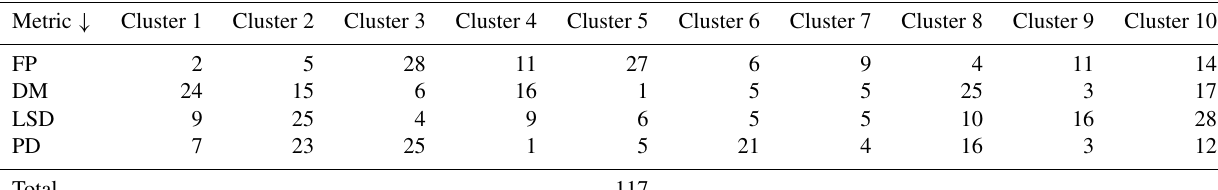
Figure 20. Variation in fracture orientations and topological summary for Region 2 corresponding to (a) fingerprint distance, (b) D-measure, and (c) portrait divergence. Table 6. Summary of subgraphs within each cluster of Region 3 for k =